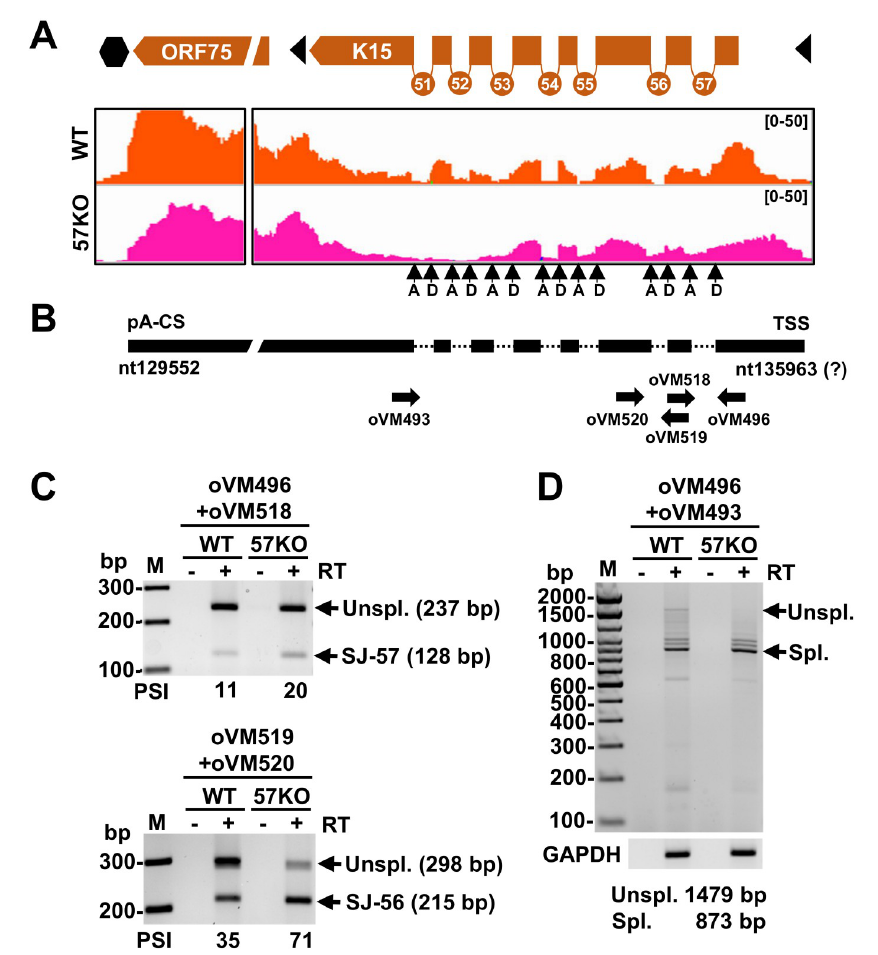
Fig 9. ORF57 regulates K15 RNA alternative splicing. (A) The splice junctions and RNA-seq coverage of K15 transcripts detected in BCBL-1 cells bearing a WT (orange) or 57KO genome (pink) during KSHV lytic infection. Black arrows mark splice donor (D) and acceptor (A) sites. (B) Structure of the K15 pre-mRNA with the position of mapped pA cleavage site (CS) and predicted transcriptional start site (TSS). The thick black lines represent the exons and the dotted lines the introns. The arrows below show the positions and orientations of the primers used in RT-PCR listed in the S6 Table . (C and D) Gel electrographs of RT-PCR products obtained from total RNA from the WT and 57KO genomes in BCBL-1 cells undergoing lytic replication harvested 24 h after VA treatment, with the primer pairs shown in (B). The samples without reverse transcription (- RT) were used as a negative control. The host GAPDH was used as a loading RNA control. Unspl., unspliced pre-mRNA; Spl., spliced mRNA; PSI, percent spliced-in of the alternative exon (s) or splice site (% inclusion = inclusion/sum of inclusion + exclusion)